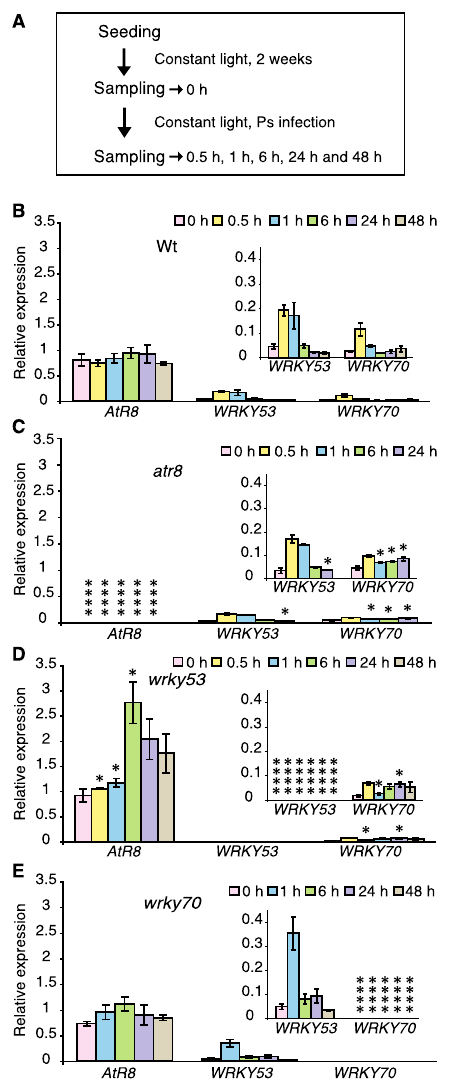
Figure 6. Short-term change of RNA levels by infection of plant pathogen Pseudomonas syringae (Ps). ( A ) Timeline of experimental procedure. AtR8 lncRNA, WRKY53 , and WRKY70 in Arabidopsis plants were treated with Ps, which was cultured with 500 µ l of King’s liquid medium and suspended in 50 mL of sterile water (100 times dilution). RNA accumulation levels of AtR8 lncRNA, WRKY53 , and WRKY70 mRNAs with Ps were compared by RT-qPCR with ACT2 and ACT8 genes as standards. Bar graphs represent the mean values of three independent assays (more than 50 plants), and error bars represent ± SE. The X-axis magnified bar graphs are superimposed in each graph. Significant di ff erences in RNA accumulations levels between Wt ( B ) and each of the mutants ( C – E ) are indicated as * p < 0.05 and **** p < 0.0001 (Welch’s t -test).